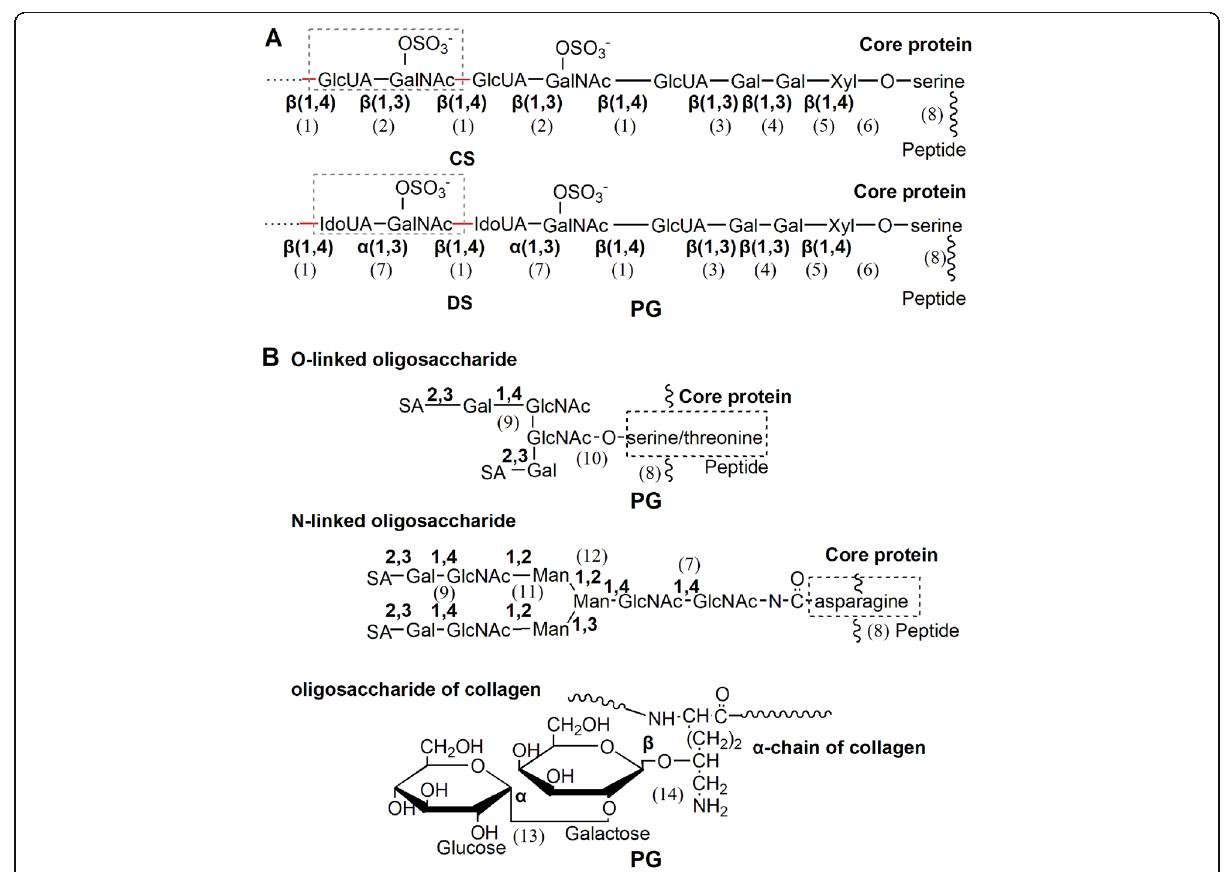
Fig. 9 Possible glycosidase hydrolysis sites in the glyco-protein conjugates in